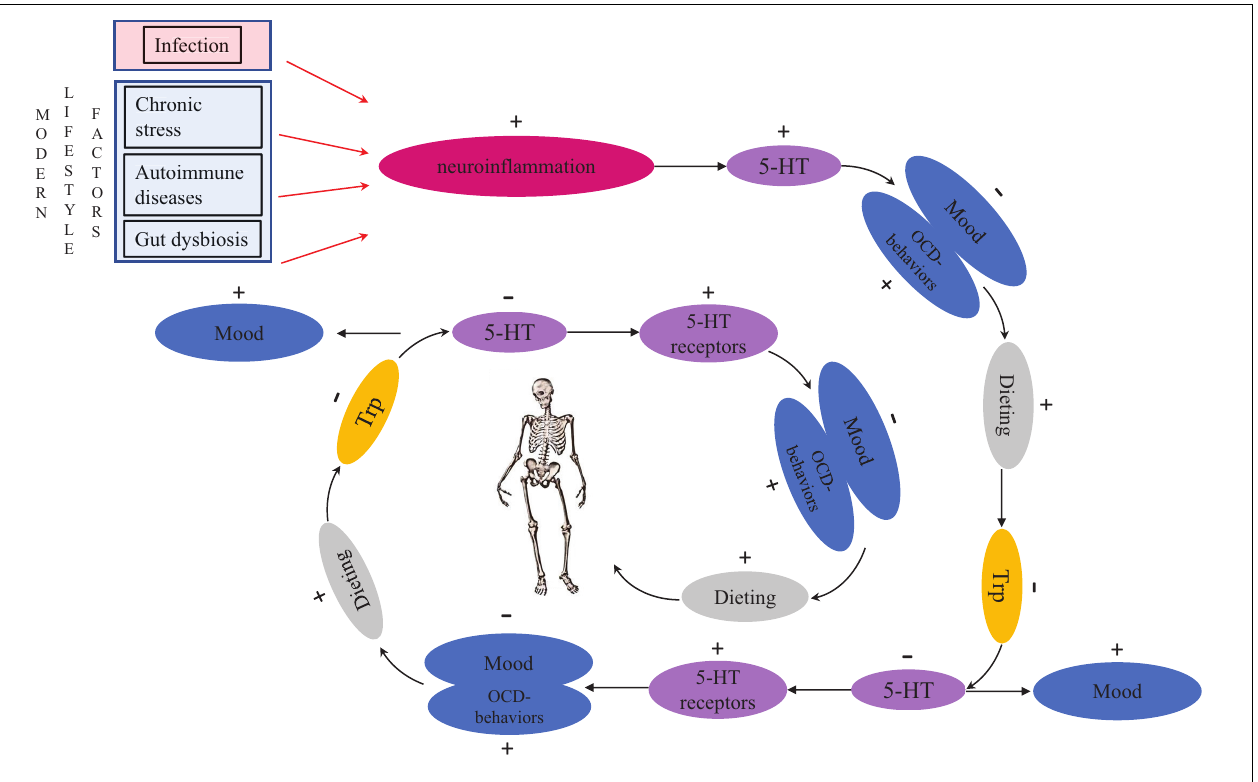
FIGURE 1 | The vicious, potentially fatal serotonergic-homeostatic stress/starvation cycle that leads to anorexia nervosa. TRP, tryptophan; 5-HT,